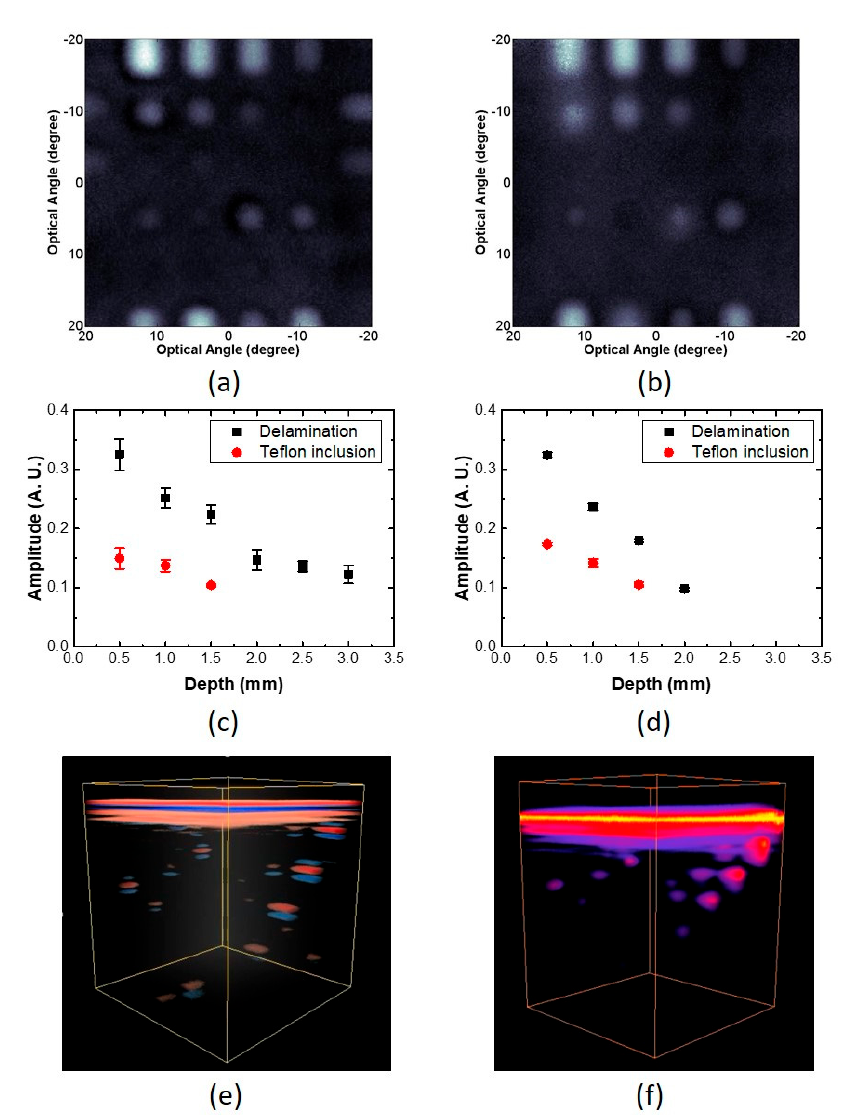
Figure 6. ( a ) C-scan image, ( c ) THz signal amplitude versus defect depth, and ( e ) 3D image of sample C obtained using the time-domain THz tomography system. ( b ) C-scan image, ( d ) THz signal amplitude versus defect depth, and ( f ) 3D image of sample C obtained using the frequency-domain THz tomography